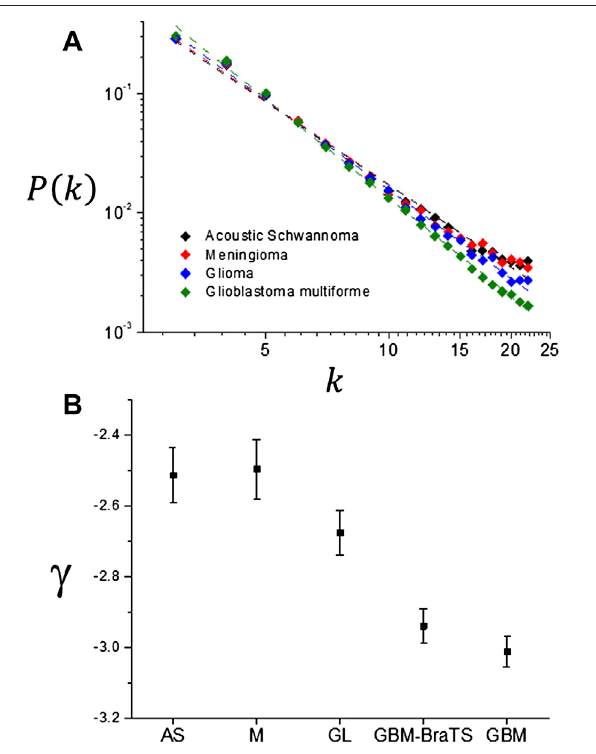
FIGURE 12 | (A) Detail of the power law region for the visibility graph degree distributions. (B) Exponent γ dependence on tumor type.